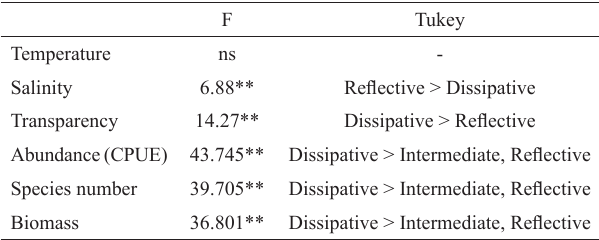
Table 1. Results from ANOVA for comparisons of abiotic (temperature, salinity and transparency) and biotic (CPUE, Species number and Biomass) factors between beaches and hydrological regime in the Mamanguape River estuary, Brazil.